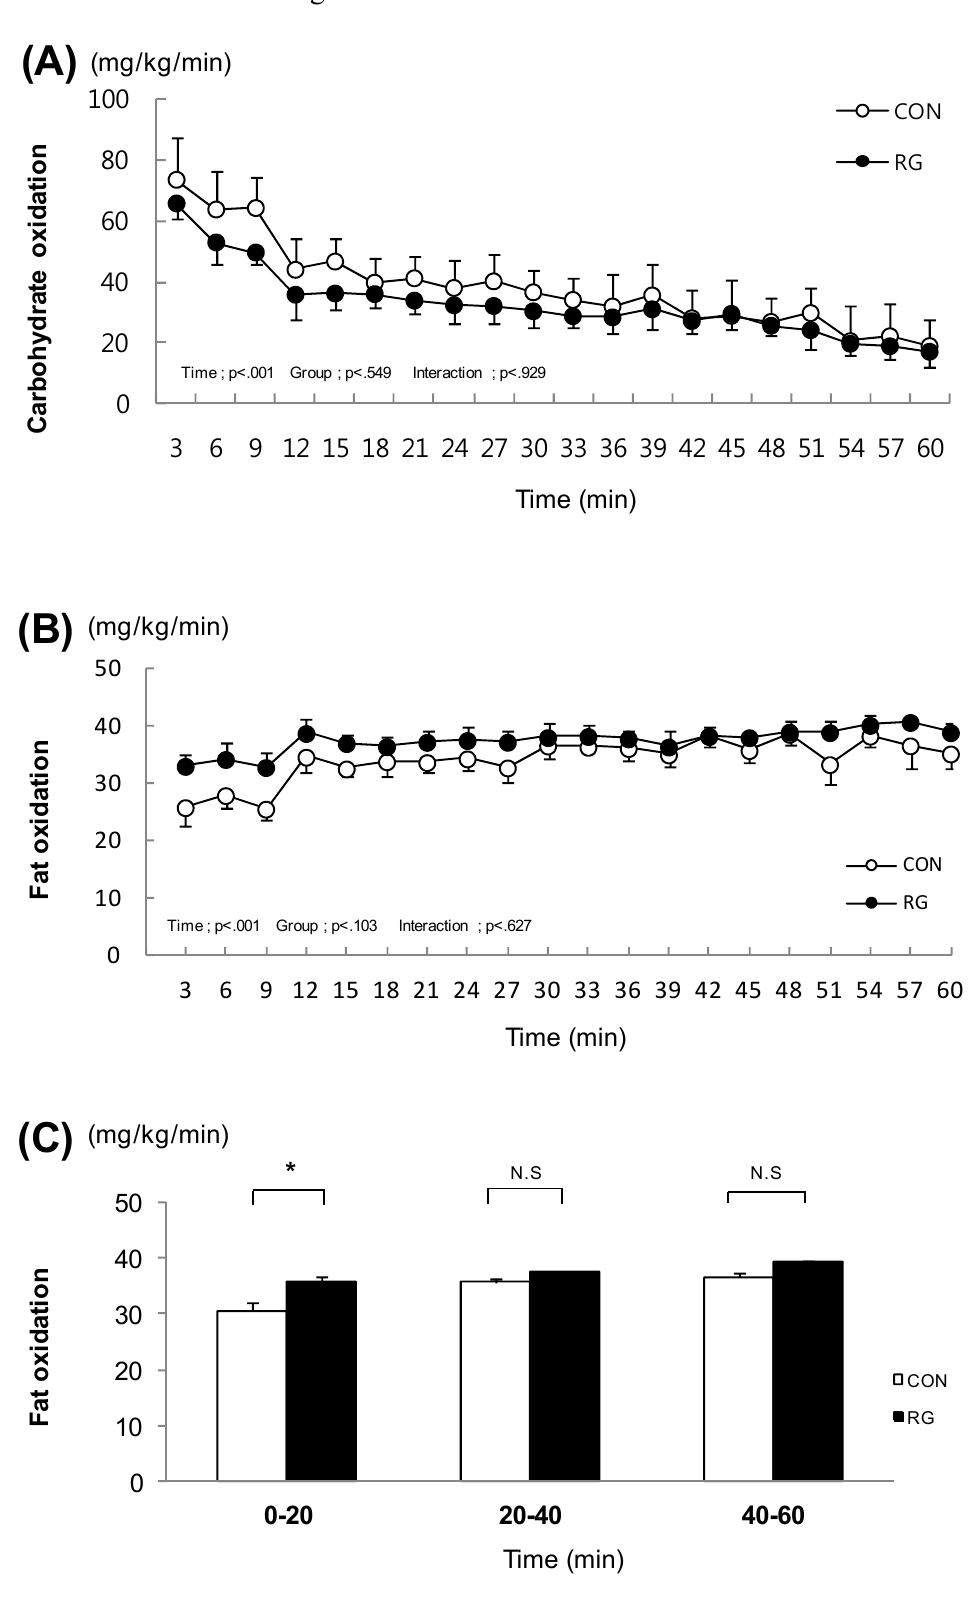
Figure 1. The change in carbohydrate oxidation and fat oxidation during exercise for 1 h. ( A ). The change in carbohydrate oxidation during exercise for 1 h; ( B ). The change in fat oxidation during exercise for 1 h; ( C ). Fat oxidation at every 20 min. Values are presented as means ± standard error ( n = 21). * vs. CON p < 0.05; CON: no treatment with training, RG: RG treatment with